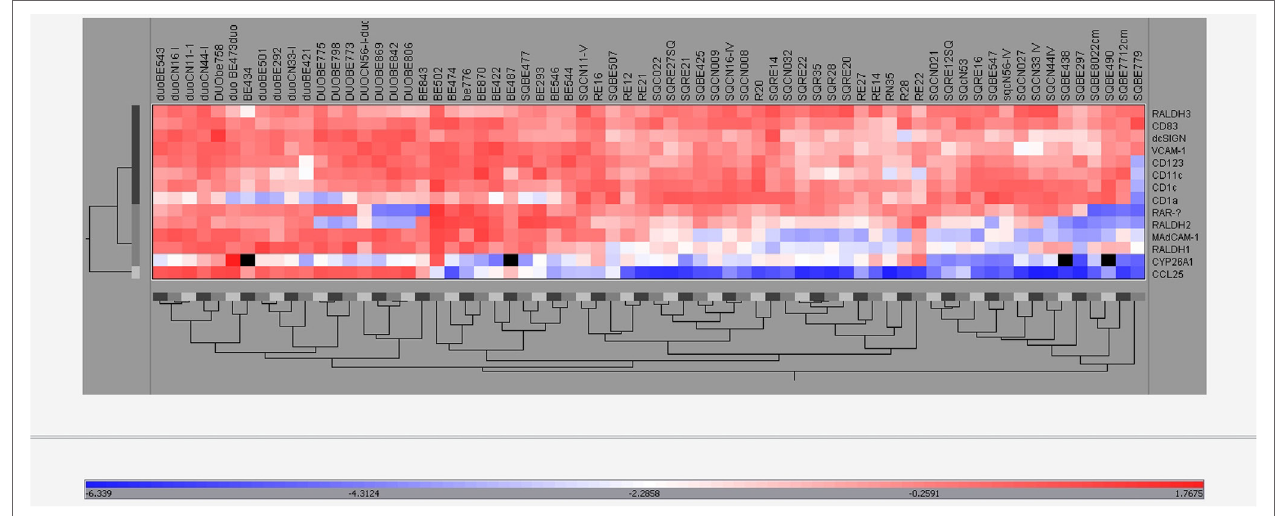
FigUre 8 | Hierarchical clustering of real-time-PCR data. The expression of all different mRNAs of all groups (BE, BE tissue; SQBE, squamous esophageal tissue from BE patients; DUOBE, duodenal tissue from BE patients; RE, inflamed esophageal tissue from RE patients; SQRE, non-inflamed squamous esophageal tissue from RE patients; SQC, esophageal tissue from controls; DUOC, duodenal tissue from controls) were